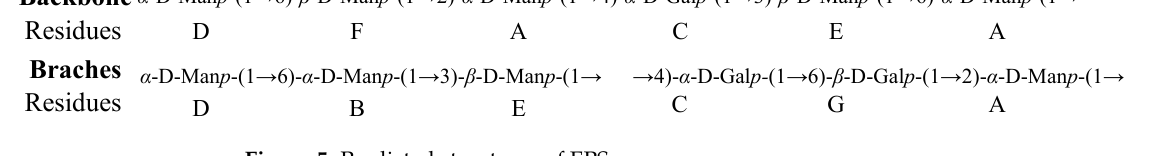
Figure 5. Predicted structures of EPSs.